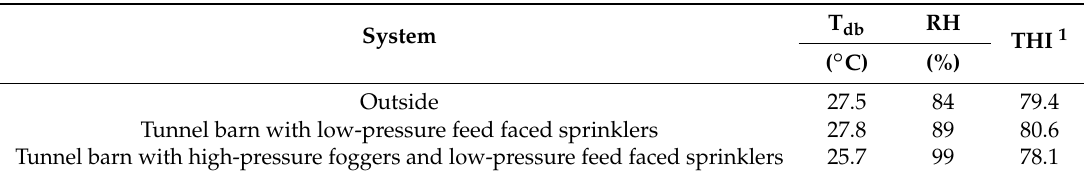
Table 5. Meteorological attributes and THI calculations between different housing systems for dairy cows in the study of Bucklin et al.